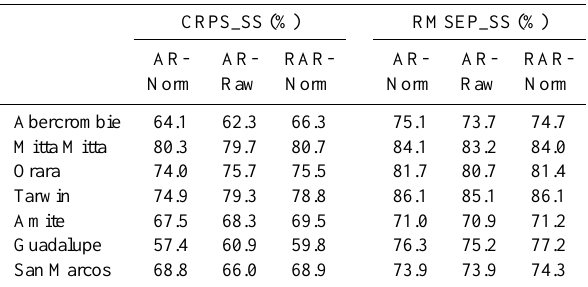
Table 3. Comparison of the skill scores based on CRPS and RMSEP (denoted by CRPS_SS and RMSEP_SS) for three different error